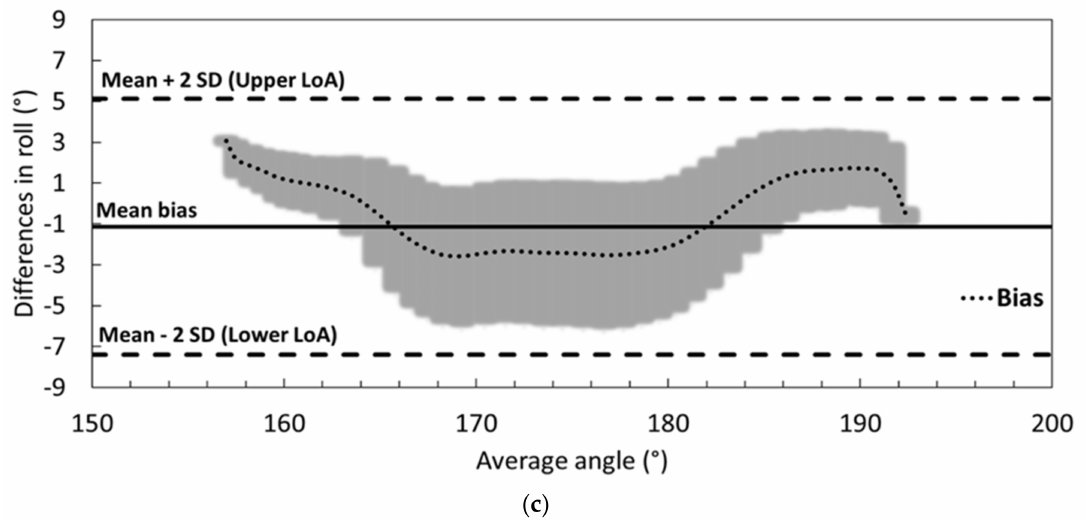
Figure 5. Differences between systems for ( a ) yaw, ( b ) pitch, and ( c ) roll for the 40-turn study for the three participants’ aggregated data (1-min study). Dotted lines shows biases and shaded areas their standard deviations as a function of the average angle. Positive and negative values indicate underestimation and overestimation of the IMU-based system, respectively. Mean biases and LoA (Mean + 2 · SD) from Table 3 are also represented as solid and dashed straight lines, respectively.